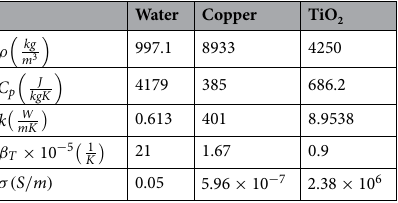
Table 1. Physical attributes of water, copper, and titanium dioxide 42,43